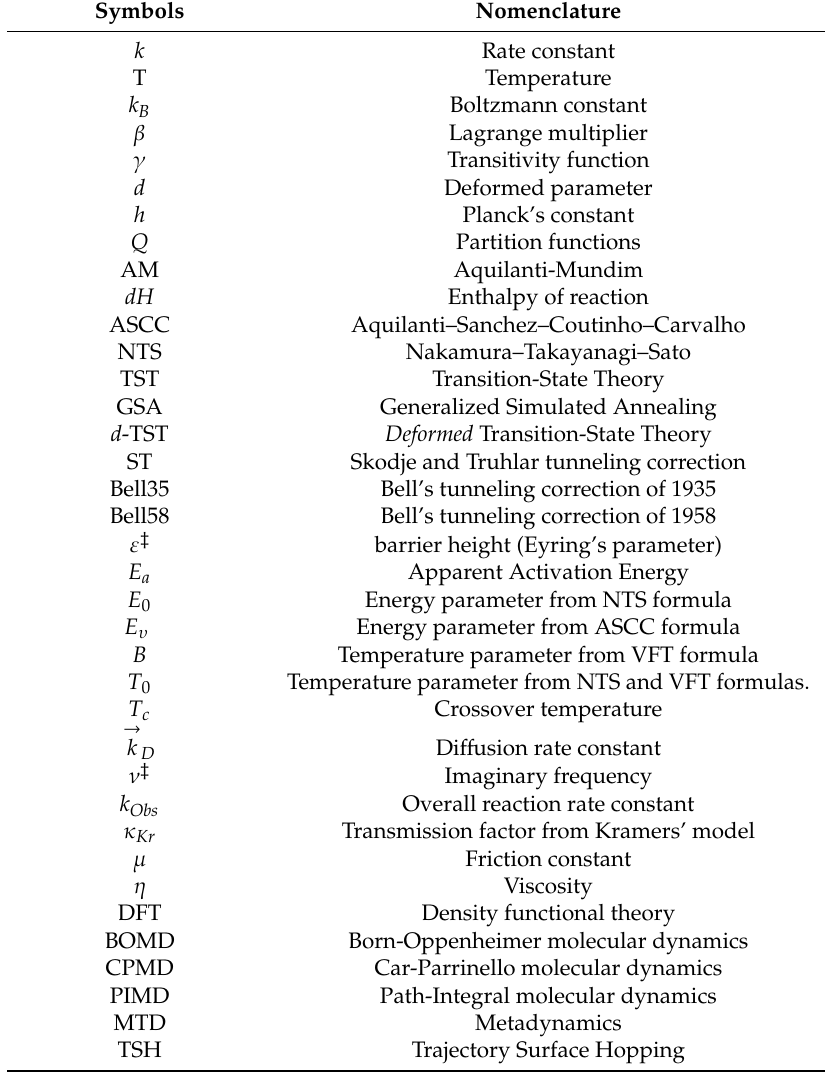
Table A1. List of Symbols and Nomenclatures.